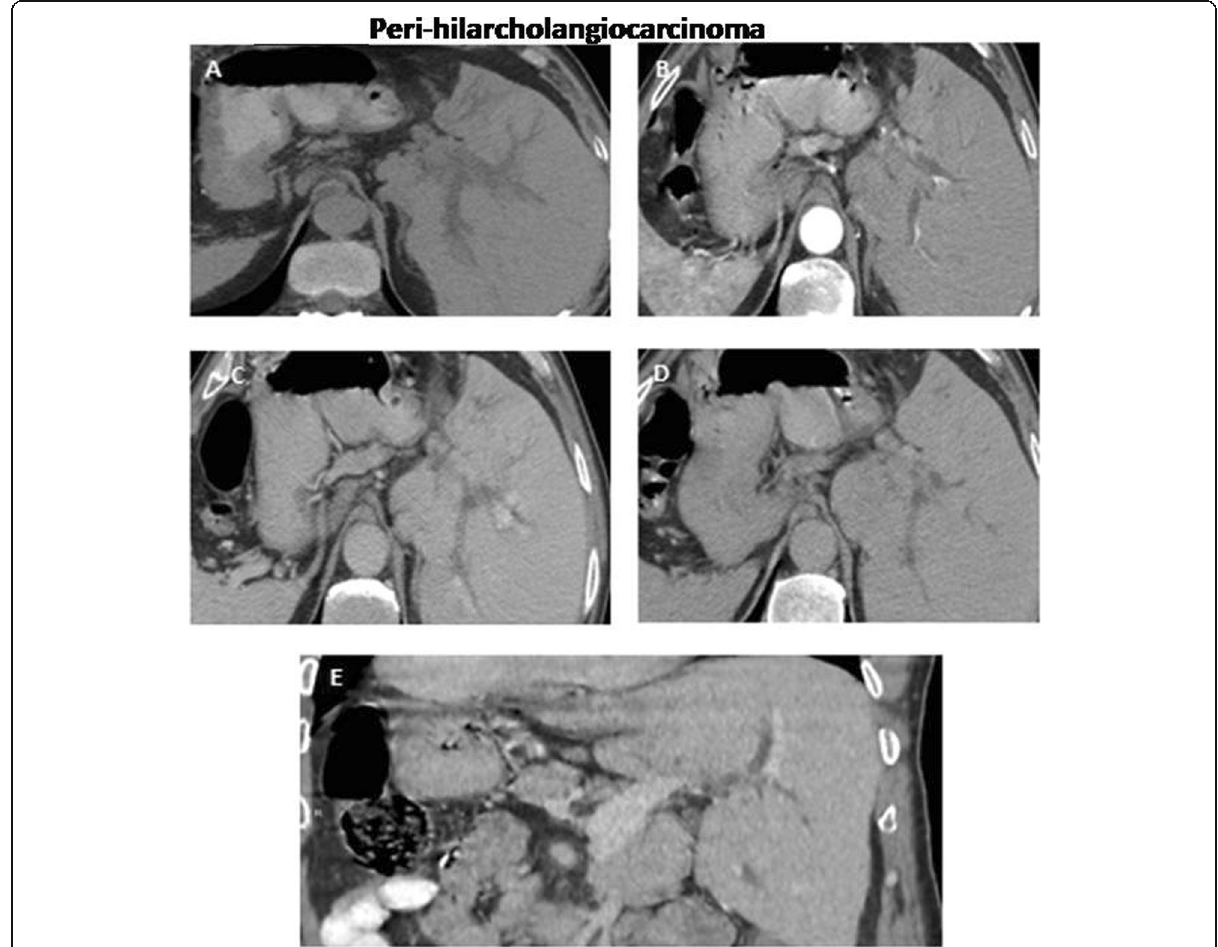
Fig. 4 Peri-hilarcholangiocarcinoma. Malignant obstructive jaundice due to common hepatic duct confluence peri-hilarcholangiocarcinoma (pathologically proved) exerting mild biliary obstruction in the patient with situs inversustotalis. Male patient, 58 years old, presented with intermittent attacks of jaundice and pruritus. a Axial non-contrast image showing a situs inversustotalis patient with mild left and right intra- hepatic biliary dilatation that stopped abruptly at the level of confluence of the hepatic ducts. b – d Axial contrast (arterial, portal, and delayed phases) images showing soft tissue mass at the common hepatic duct extending to hepatic ductal bifurcation that showed faint arterial phase enhancement and no enhancement at the portal and delayed phases. e Coronal oblique reformatted MDCT cholangiography image shows the soft tissue mass at the common hepatic